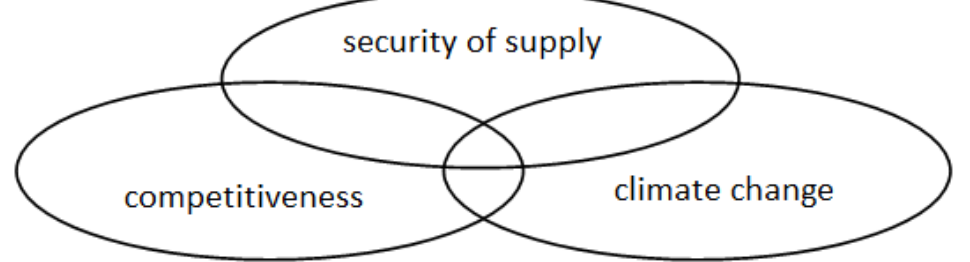
Figure 3. The triad of goals of the European Union (EU)’s climate and energy policy in the 2030 perspective. Source: own study.